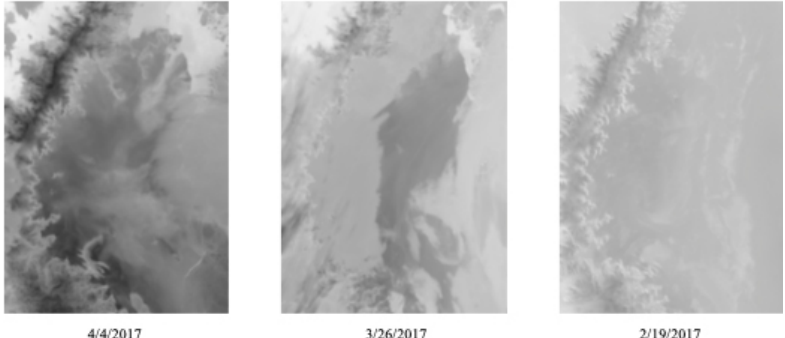
Figure B8. Example of noisy images that have been excluded when computing the average image. Raw images sourced from Scambos et al.